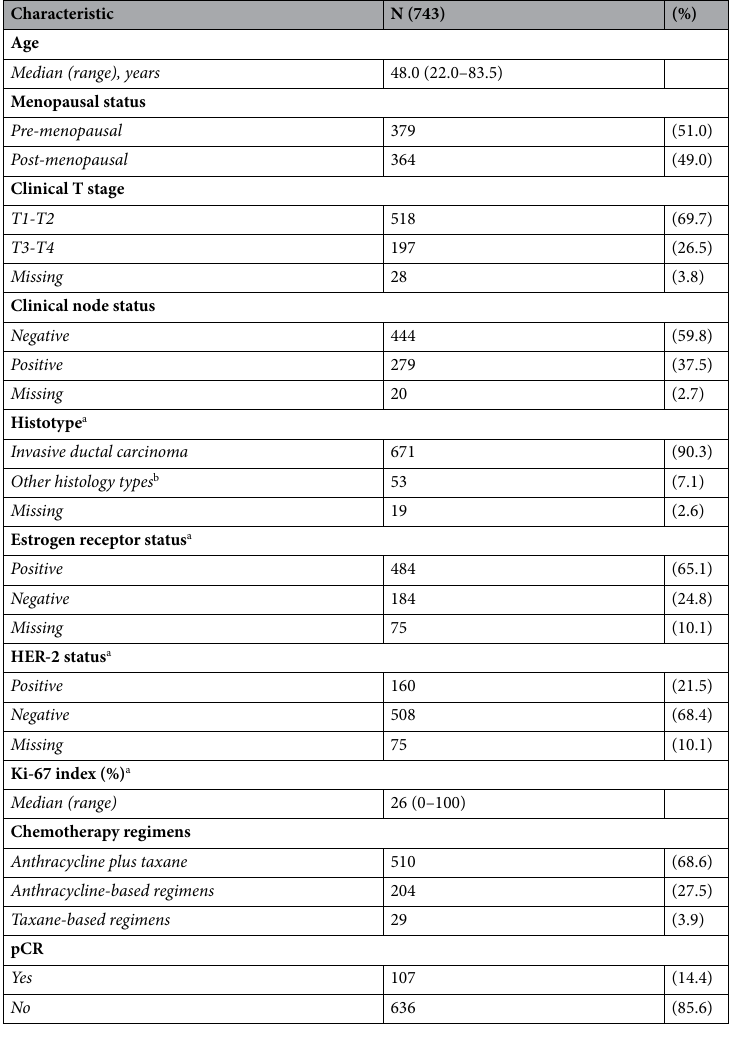
Table 1. Clinicopathological characteristics of the patients. T tumor, pCR pathological complete response, HER-2 human epidermal growth factor receptor-2. a Histopathological examination of the pre-treatment biopsy specimen. b Including lobular, mucinous, papillary, metaplastic, and mixed tumors.